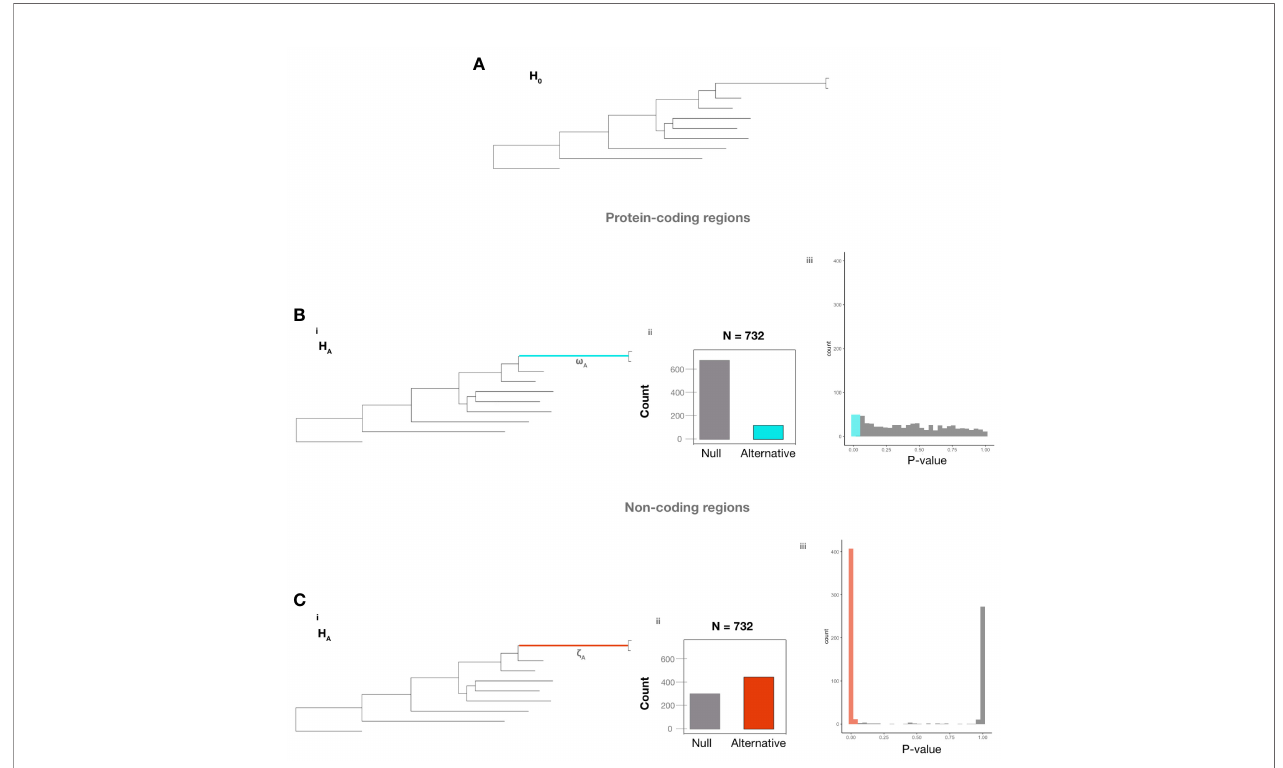
FIGURE 3 | Non-coding regions of A. fumigatus genes exhibit many more signatures of evolutionary rate difference than their corresponding protein-coding regions. (A) The null hypothesis (H 0 ) that all branches have the same evolutionary rate. (B, C) The alternative hypotheses assume that the w value (Bi) or the z value (Ci) in the branch leading to A. fumigatus differs from the value in the rest of the branches of the phylogeny. Bii. 632 of 732 protein-coding regions (84.34%) did not reject H 0 (gray) and 100 of 732 (16.66%) rejected H 0 (blue). Biii. The distribution of p-values for protein-coding regions that did not (gray) and did (blue) reject H 0 . Cii. 314 of 732 non-coding regions (42.90%) did not reject H 0 (gray) and 418 of 732 non-coding regions (57.10%) rejected H 0 (red), which suggests a greater amount of variation in non-coding regions than in protein-coding regions between A. fumigatus and relatives. Ciii The distribution of p-values for non-coding regions that did not (gray) and did (red) reject H 0